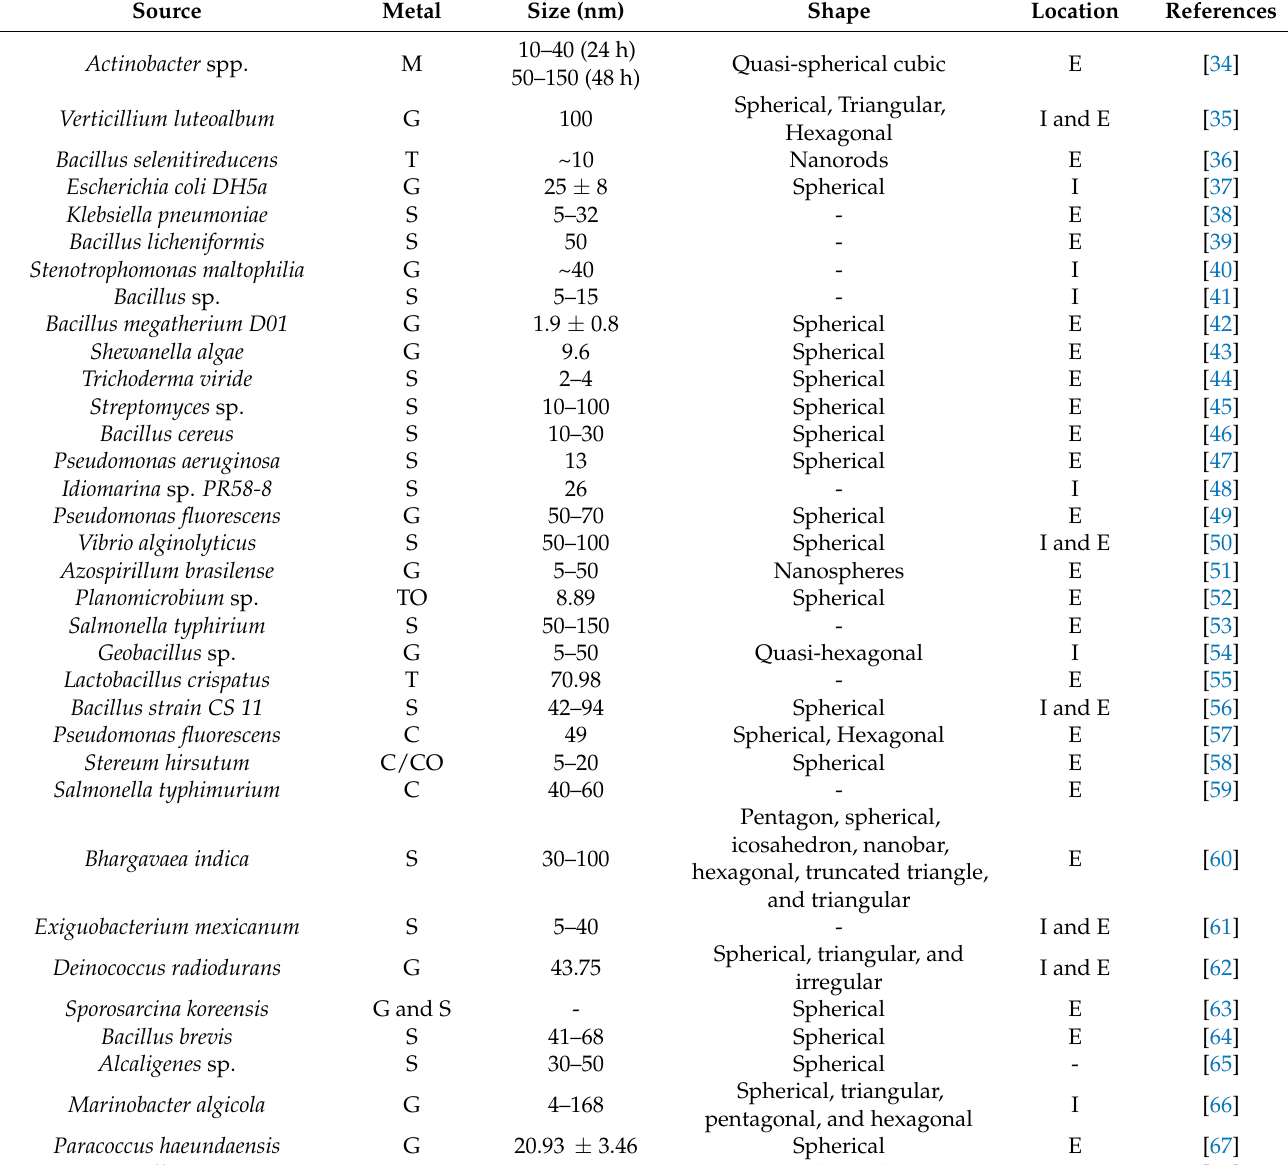
Table 1. Nanoparticles synthesized from